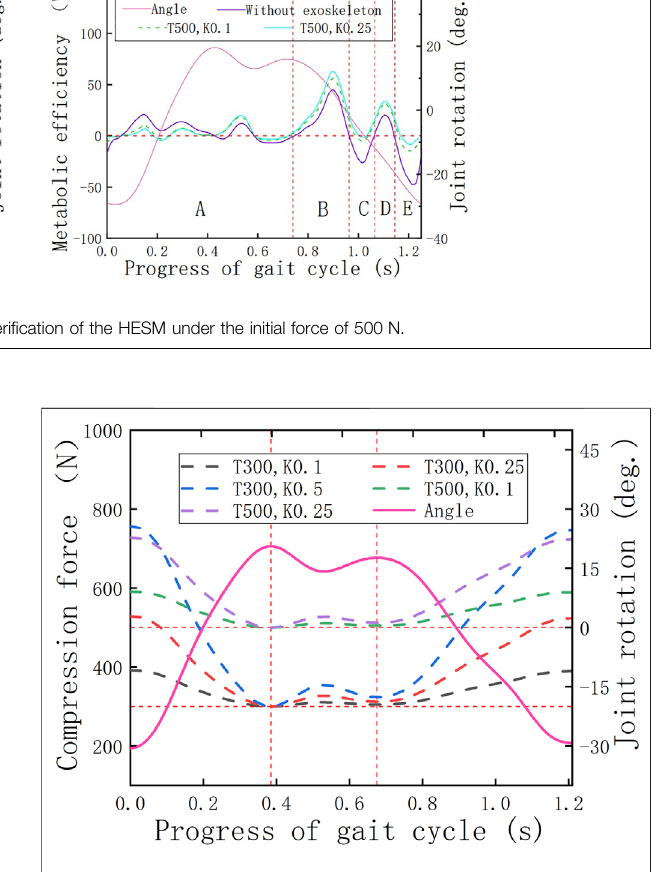
FIGURE 9 | Tension changes of the hip